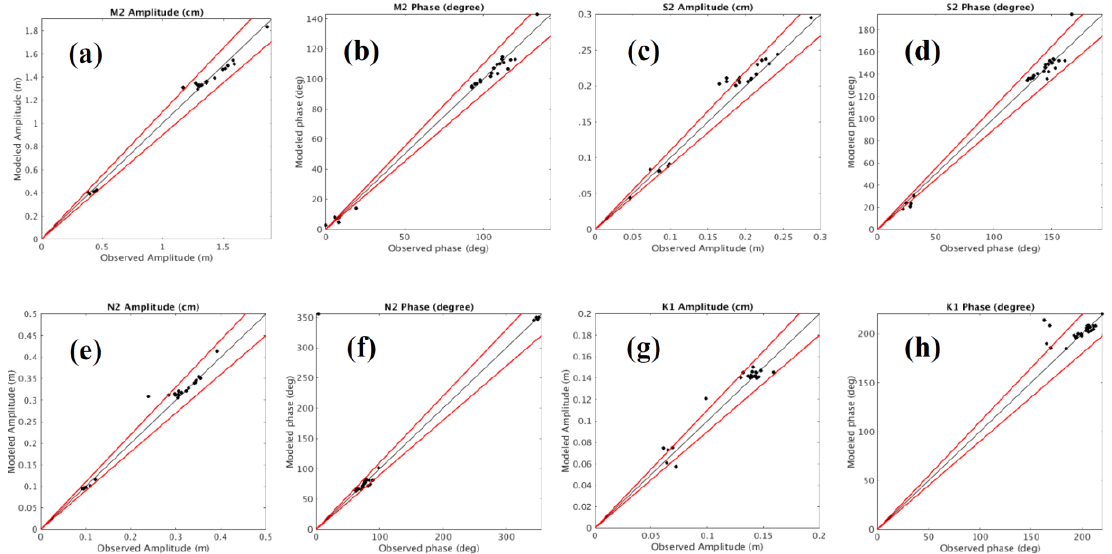
Figure 3. Scatter plots of the tidal harmonic constants (amplitudes and phases) of M 2 , N 2 , S 2 , and K 1 constituents between model results and observations. The red lines on each plot outline the ten percent deviation from the perfect model-data match. ( a ) M 2 amplitude; ( b ) M 2 phase; ( c ) S 2 amplitude; ( d ) S 2 phase; ( e ) N 2 amplitude; ( f ) N 2 phase; ( g ) K 1 amplitude; and ( h ) K 1 phase.